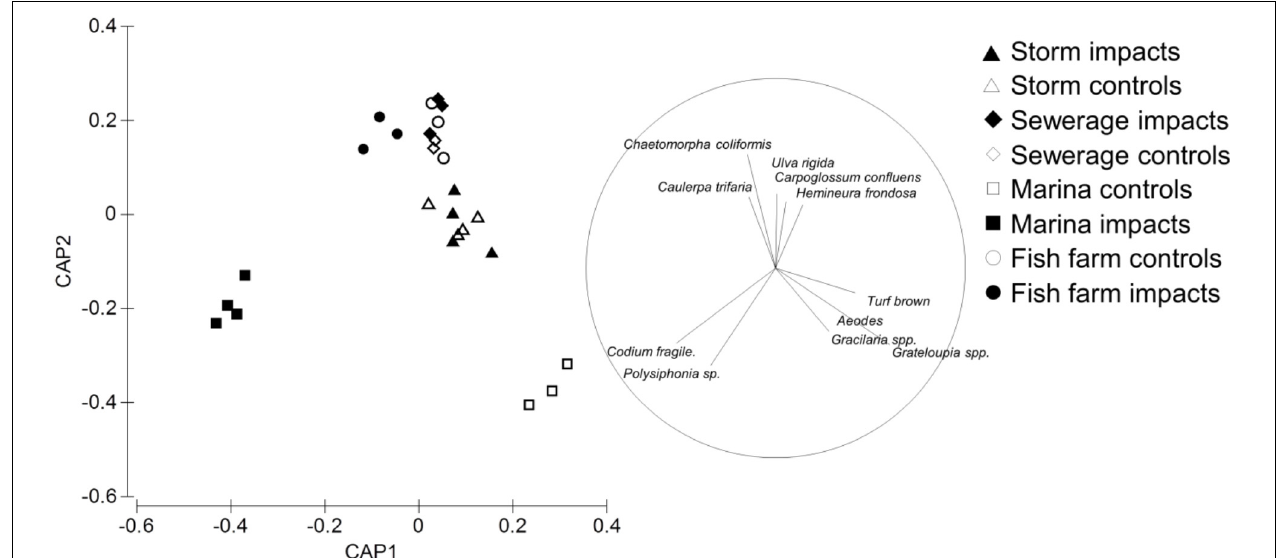
FIGURE 2 | Canonical analysis of principal coordinates (CAP) ordination showing differences in the recruited sessile assemblage on pavers near anthropogenic point sources (solid symbols) relative to their paired control sites (open symbols). Taxa that contributed to the greatest dissimilarity between the impact and paired control sites are shown by vector plot, with circle diameter showing correlation of 1. Anthropogenic point sources are: sew = sewerage outfall, storm = storm water drains, fish farm = fish farms, marina = marinas.